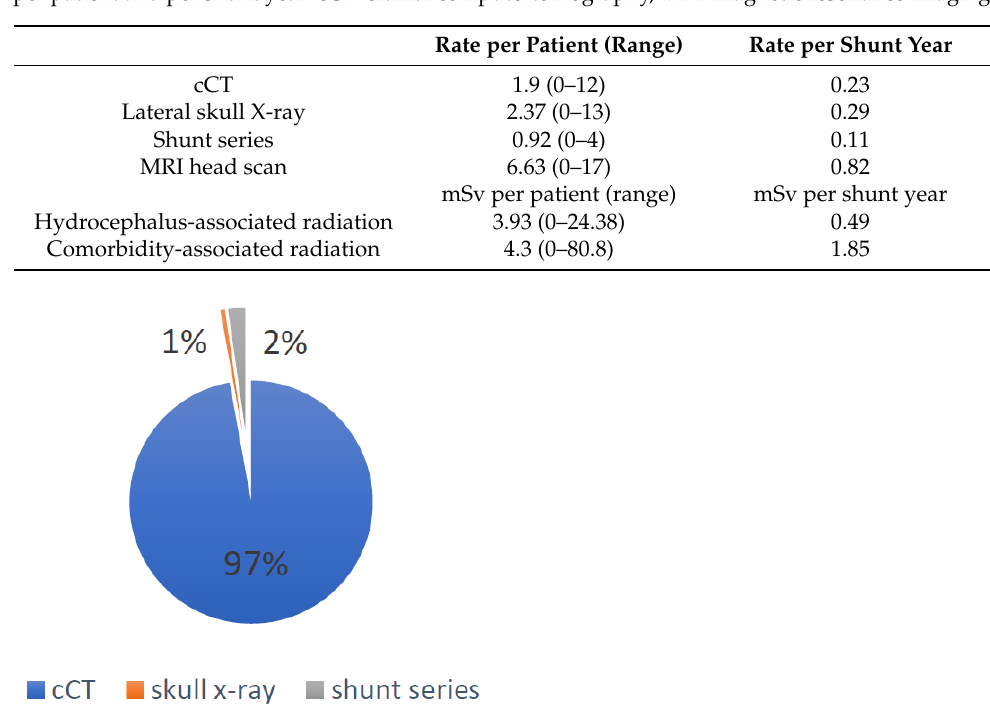
Figure 2. Visualization of the percentages of the different causes accounting for the global irradiation.